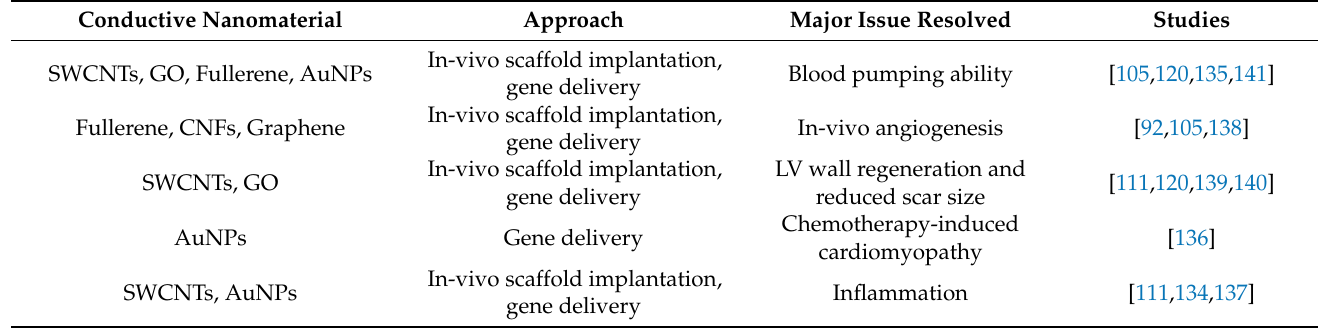
Table 8. The best possible strategy to resolve different cardiac-related issues using conductive nanomaterials. Conductive Nanomaterial Approach Major Issue Resolved Studies In-vivo scaffold implantation, SWCNTs, GO, Fullerene, AuNPs gene delivery In-vivo scaffold implantation, Fullerene, CNFs, Graphene SWCNTs,